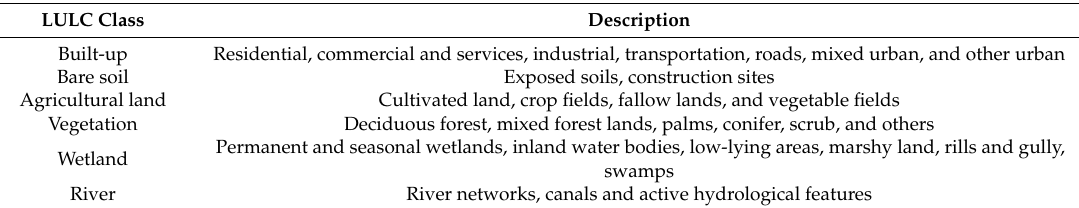
Table 1. Land cover classification scheme used in this study.